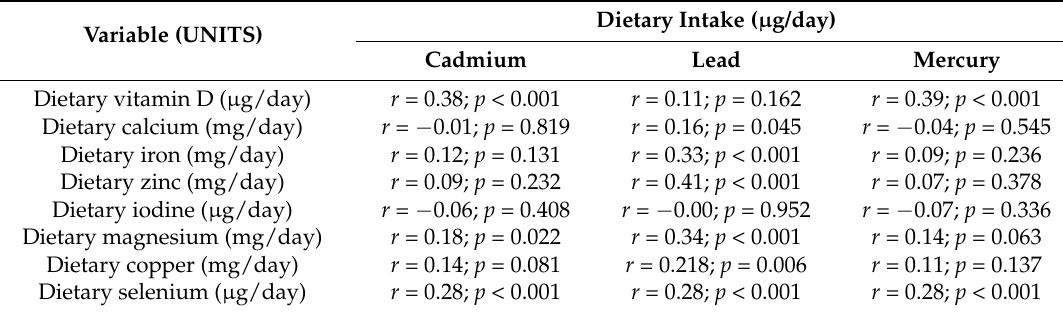
Table 7. Partial correlation results (dietary heavy metals and